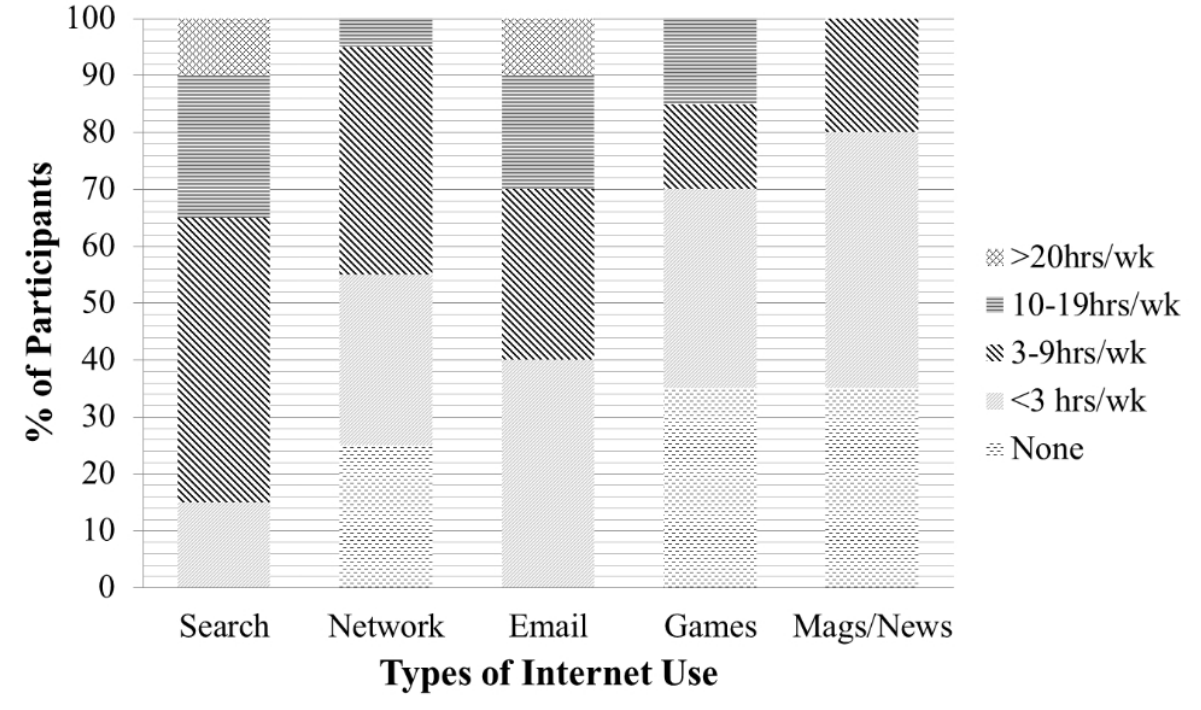
Figure 2. Type and amount of Internet